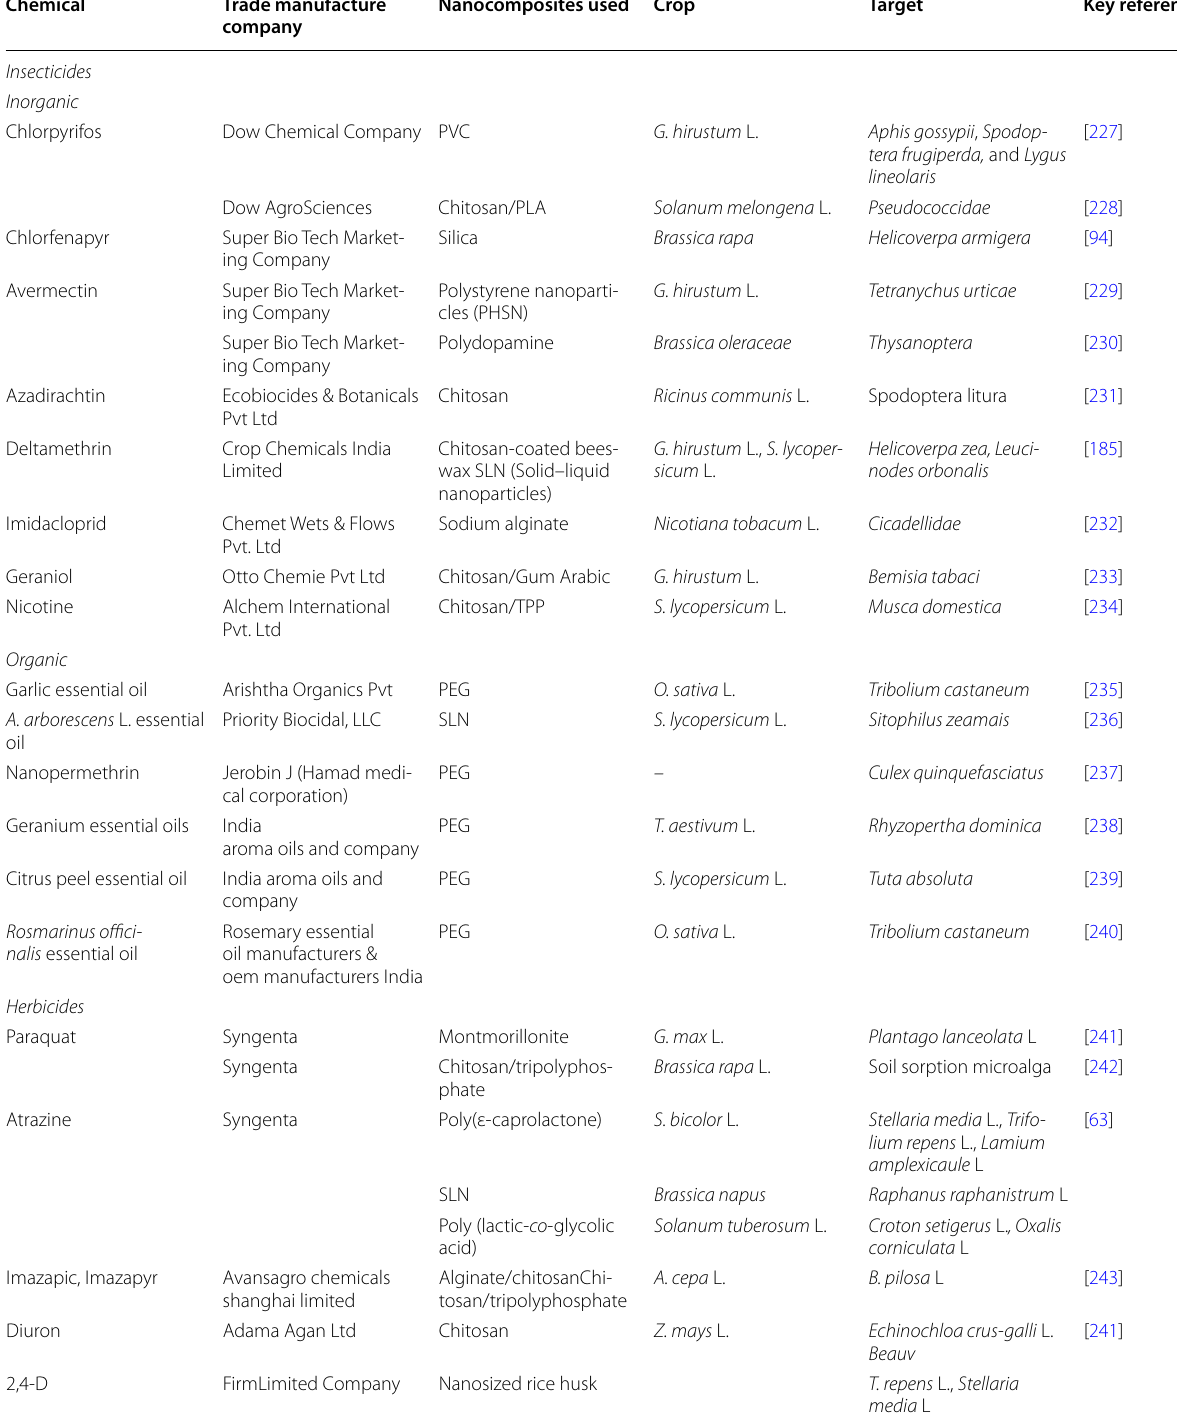
Table 5 Agrochemicals (insecticides, herbicides, and other fungicides) used to regulate the activity of crop pests under a sustainable agriculture